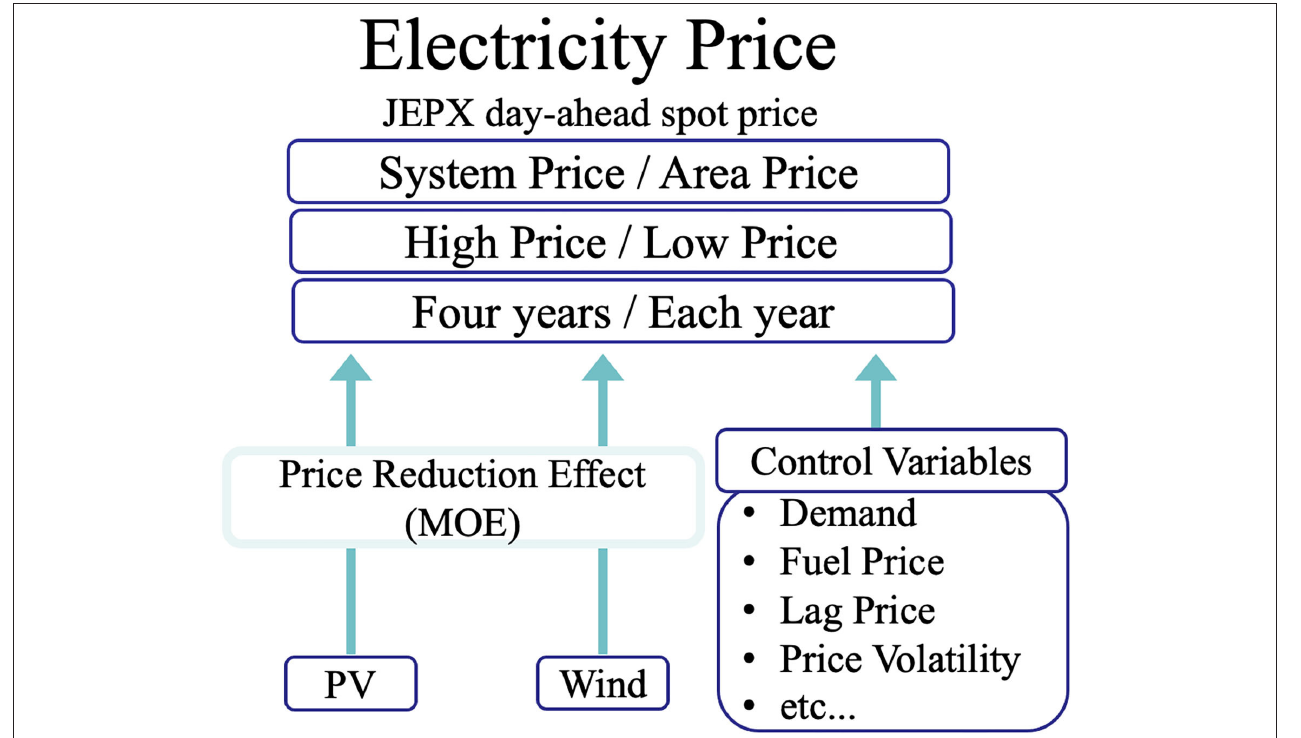
FIGURE 3 | Research framework of this study. (Source: created by